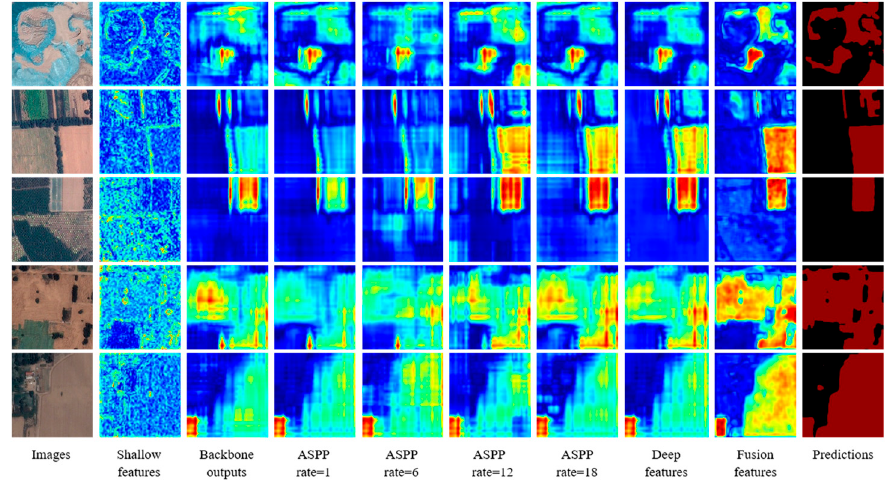
Figure 15. Visualizing convolutional networks.